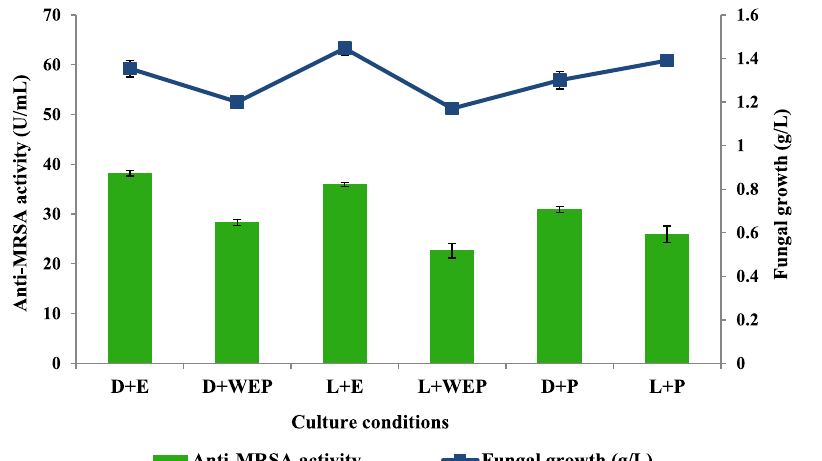
Fig. 3. Effects of growth medium and light intensity on the production of anti-MRSA activity and fungal growth by L. pseudotheobromae IBRL OS-64. Different letters indicate significant differences between means (Duncan, p<0.05). Standard deviation values of triplicate analyses are shown by error bars. [ notes : D-dark condition, WEP-without host plant extract/powder, E-host plant extract, P-host plant powder, L-in the presence of